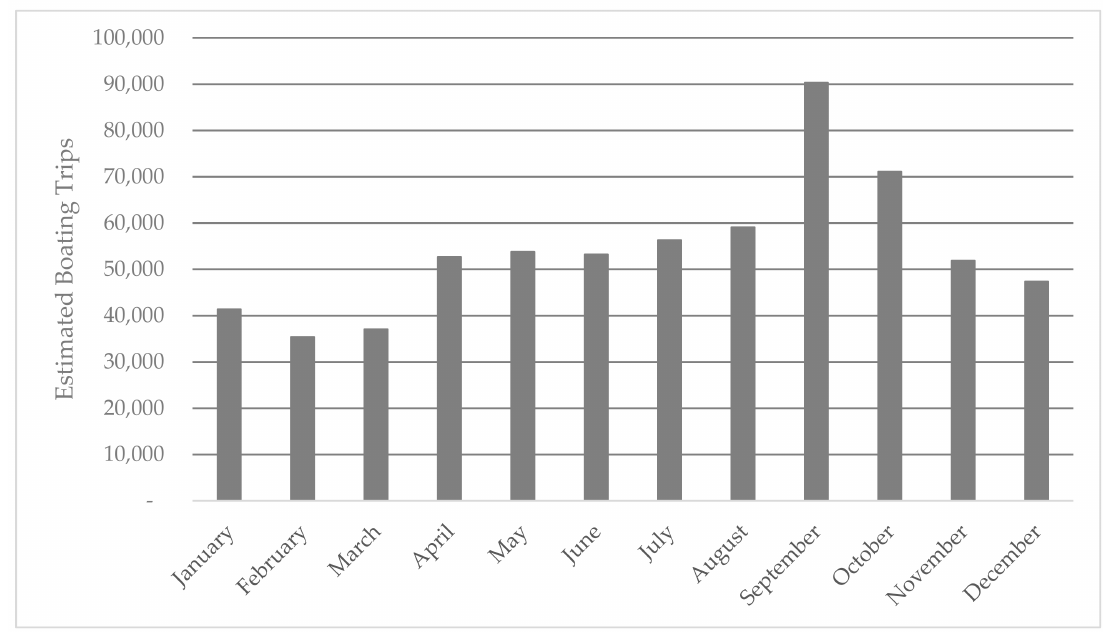
Figure 4. Estimated monthly number of boating trips to Lee County. Adapted from FWC